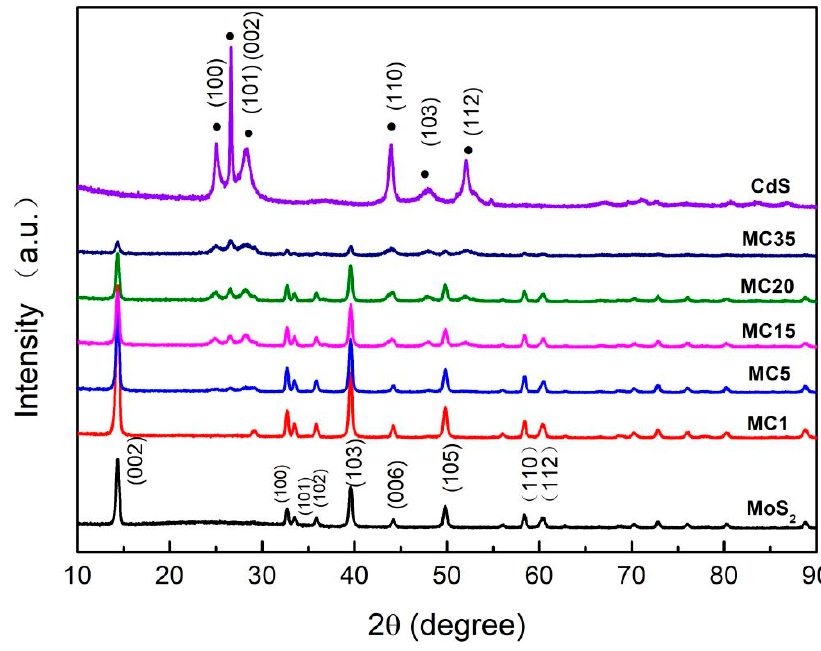
Figure 1. The X-ray diffraction (XRD) patterns of all the samples.